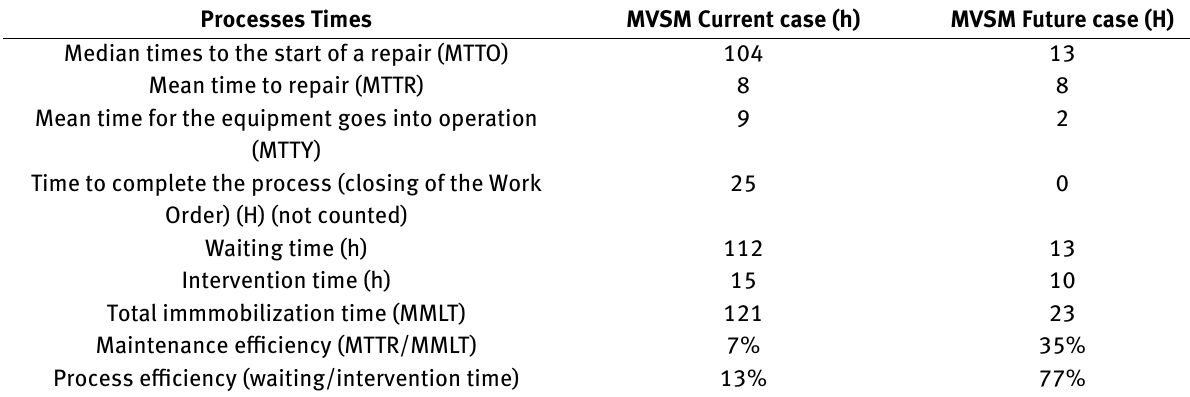
Table 3: Summary of processes